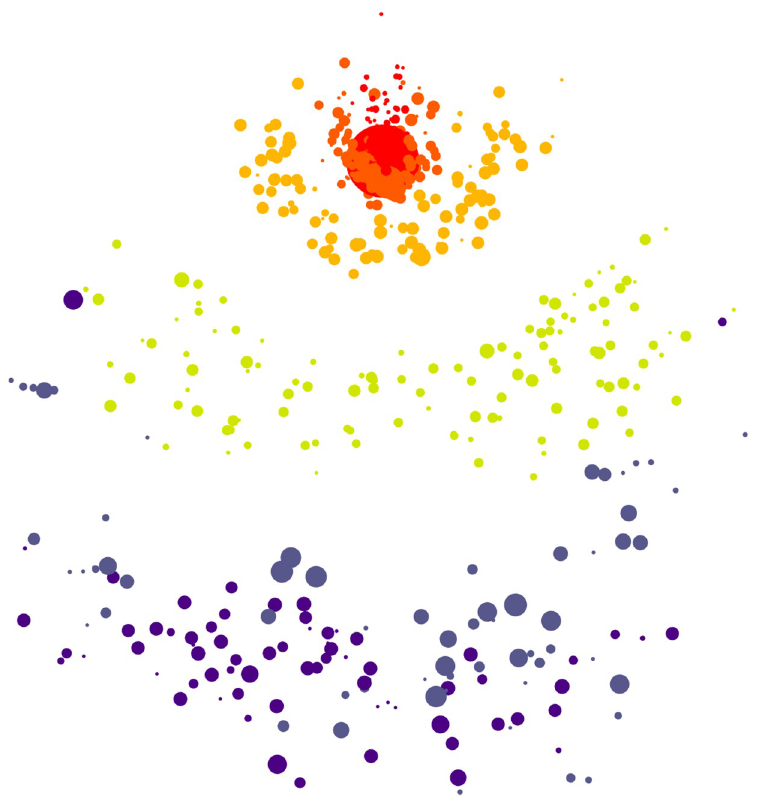
Fig 4. Screenshot of the multidimensional scaling plot. The embedding in two dimensions preserves pairwise evolutionary distances between HQCSs. Node area is proportional to copy number, and color corresponds to time point. The increasing genetic diversity of the population is visible as time goes